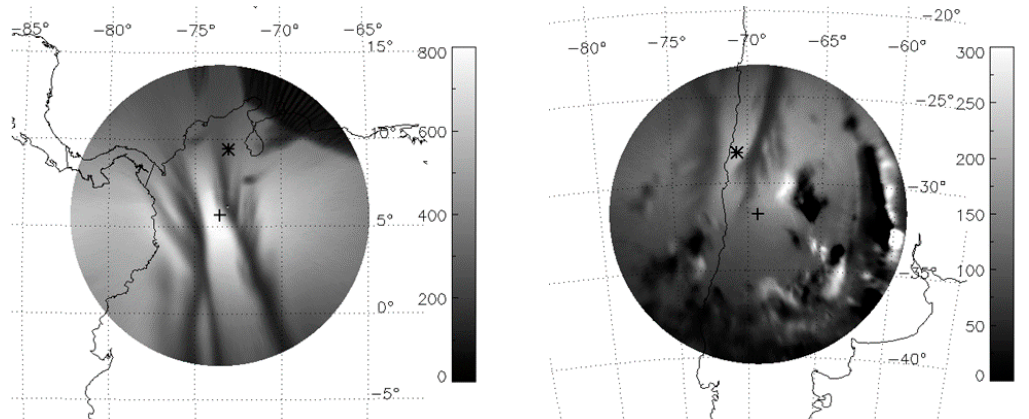
Figure 5. ( left ) Unwarped 6300 Å image from the Villa de Leyva ASI at 02:06 UT on 10 March 2015. The cross is the location of the ASI and the asterisk represents the magnetic conjugate location of El Leoncito’s zenith; ( right ) unwarped simultaneous 6300 Å image from El Leoncito ASI. The asterisk shows the magnetic conjugate location of the northern hemisphere imager’s zenith. Both images were unwarped at 250 km.